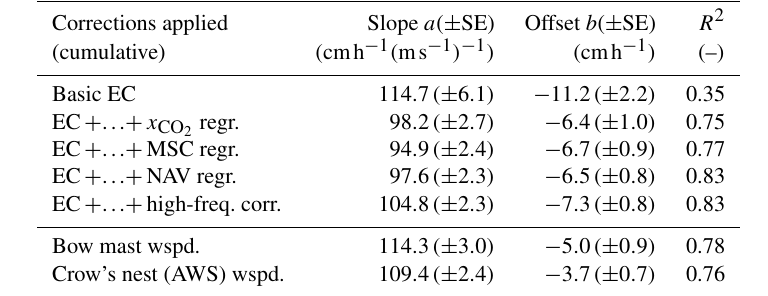
Table 1. Cumulative effect of various corrections on the relationship of gas transfer and friction velocity. Slope a and offset b with standard error ( ± SE) and coefficients of determination (R 2 ) for linear Deming regression of k 660 (CO 2 ) with u ∗ , ( k 660 = a u ∗ + b ) (Deming, 1943). The first five rows feature EC results with increasing level of corrections applied to the data. The two last rows show the results for using u ∗ (bulk) derived from the wind-speed (wspd.) measurements on the bow mast and crow’s nest (both were corrected for airflow distortion).